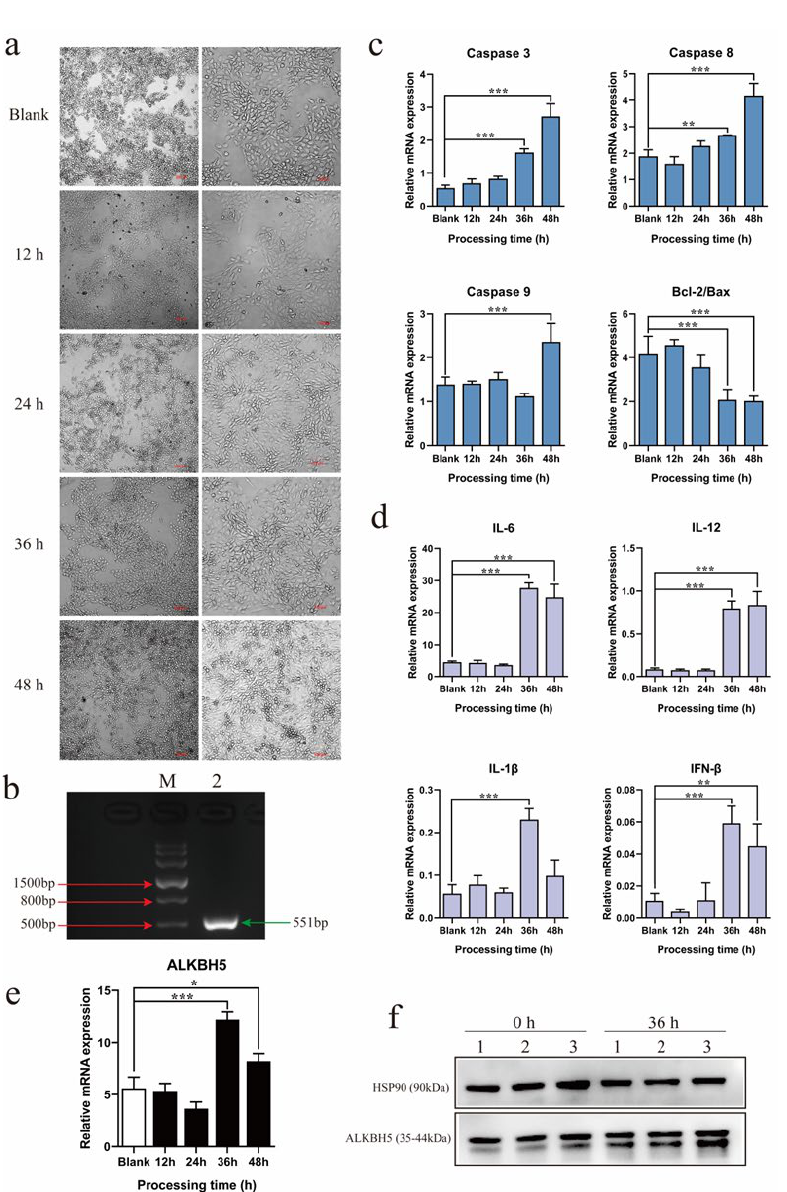
Figure 2. Effects of PEDV infection on 3D4/21 cells and ALKBH5 expression. ( a ) Phenotype of 3D4/21 cells during PEDV infection by optical microscopy. Blank: 3D4/21 cells without PEDV infection. ( b ) Agarose gel assay of PCR results against hallmark genes of viruses in PEDV-infected 3D4/21 cells. M: Marker III molecular weight standard. Lane 2 represents PEDV-M. ( c ) Effect of PEDV infection on the expression of apoptosis-related genes in 3D4/21 cells. Blank: 3D4/21 cells without PEDV infection. ( d ) Effects of PEDV infection on the expression of inflammation-related genes in 3D4/21 cells. Blank: 3D4/21 cells without PEDV infection. ( e ) ALKBH5 expression in 3D4/21 cells infected with PEDV. Blank: 3D4/21 cells without PEDV infection. ( f ) Western blotting for ALKBH5 protein abundance in 3D4/21 cells infected with PEDV for 36 h. At least three biological replicates were used for each group. Data are presented as the mean ± SD; * p < 0.05, ** p < 0.01, *** p <